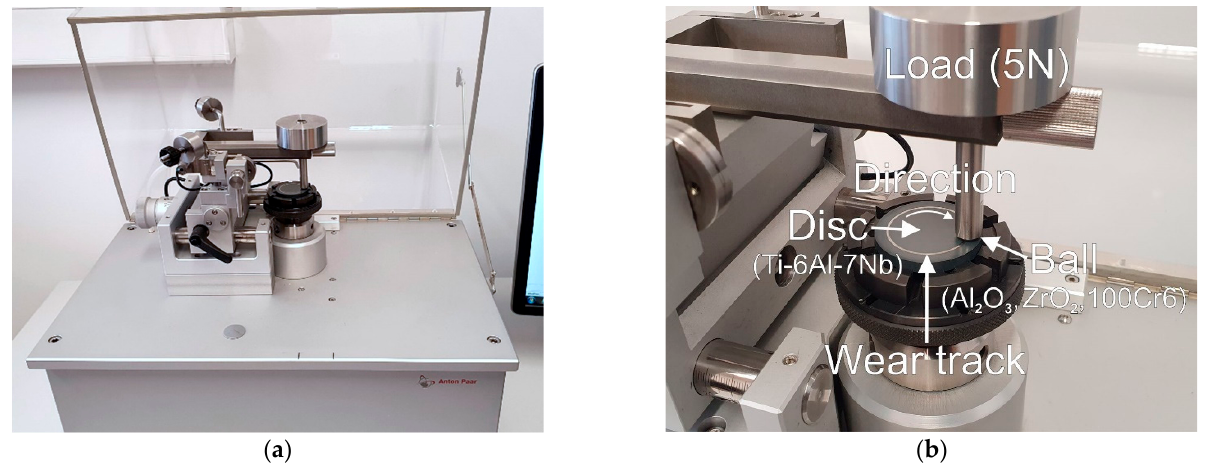
Figure 1. TRN tribometer: ( a ) general view, ( b ) detailed view of the tribological system.